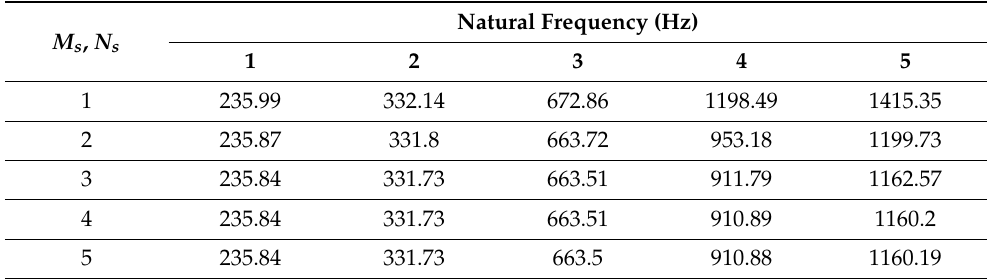
Table 1. Convergence test of thick glass/epoxy composite plate with zero fiber angle and a / h = 5 ( M b = N b =